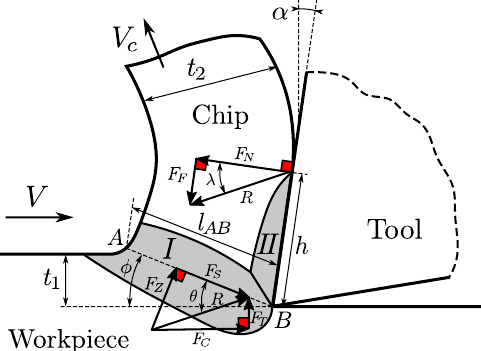
Figure 2. Chip formation conforming to Oxley’s